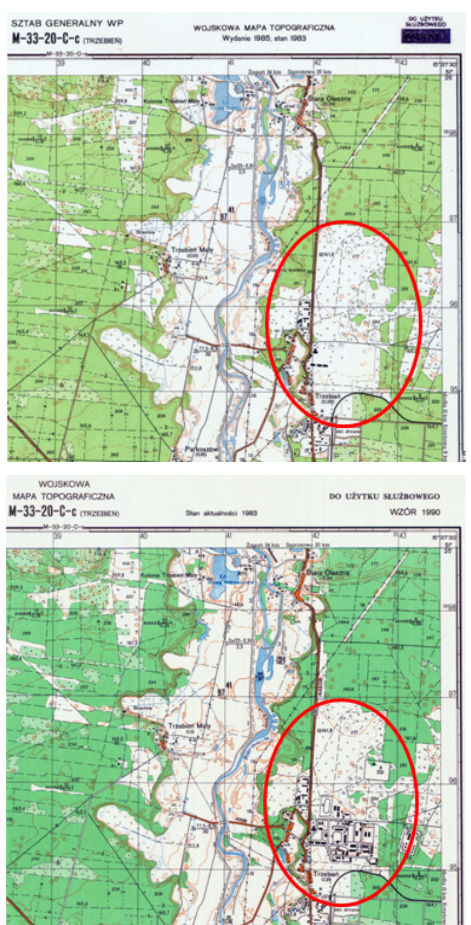
Fig. 14. The “Trzebień” facility in the Pstrąże garrison on Polish maps of various editions at the scale